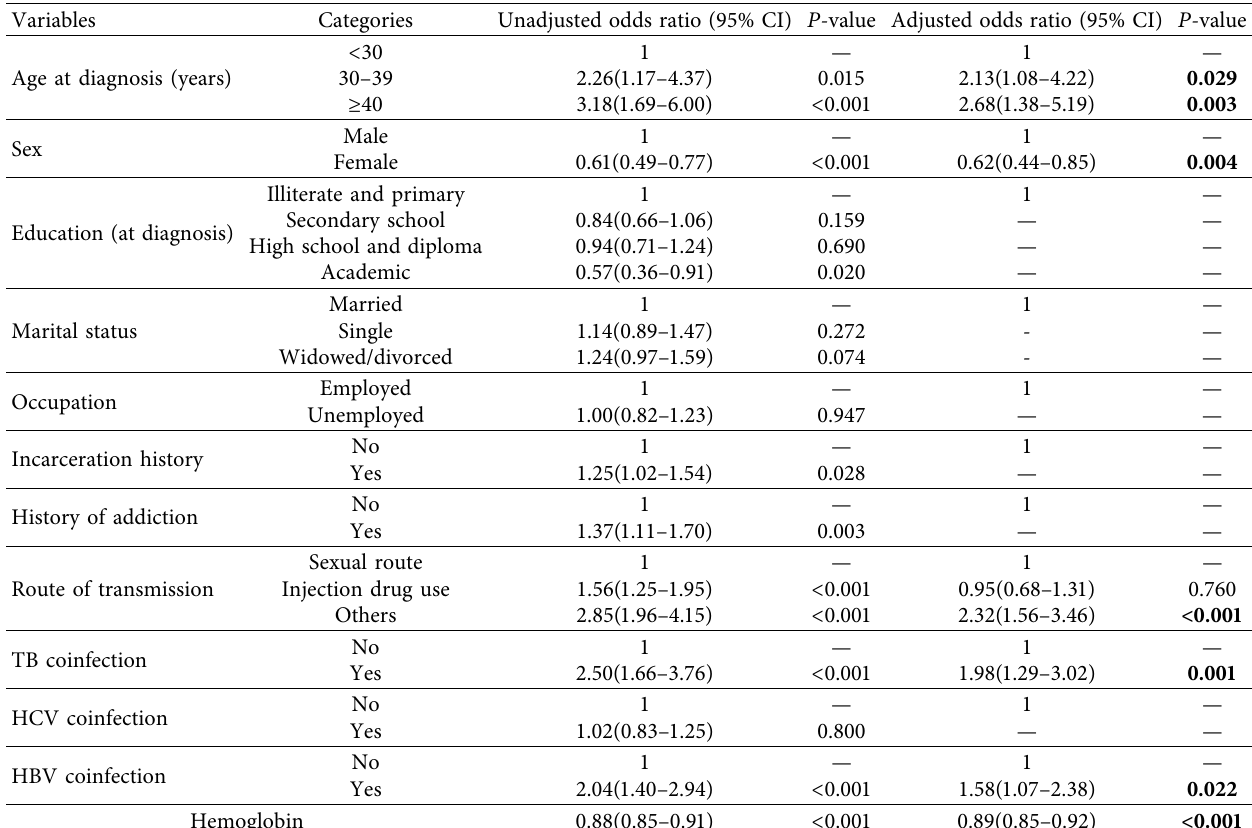
Table 3: Adjusted association of study variables with advanced HIV disease, Iran,